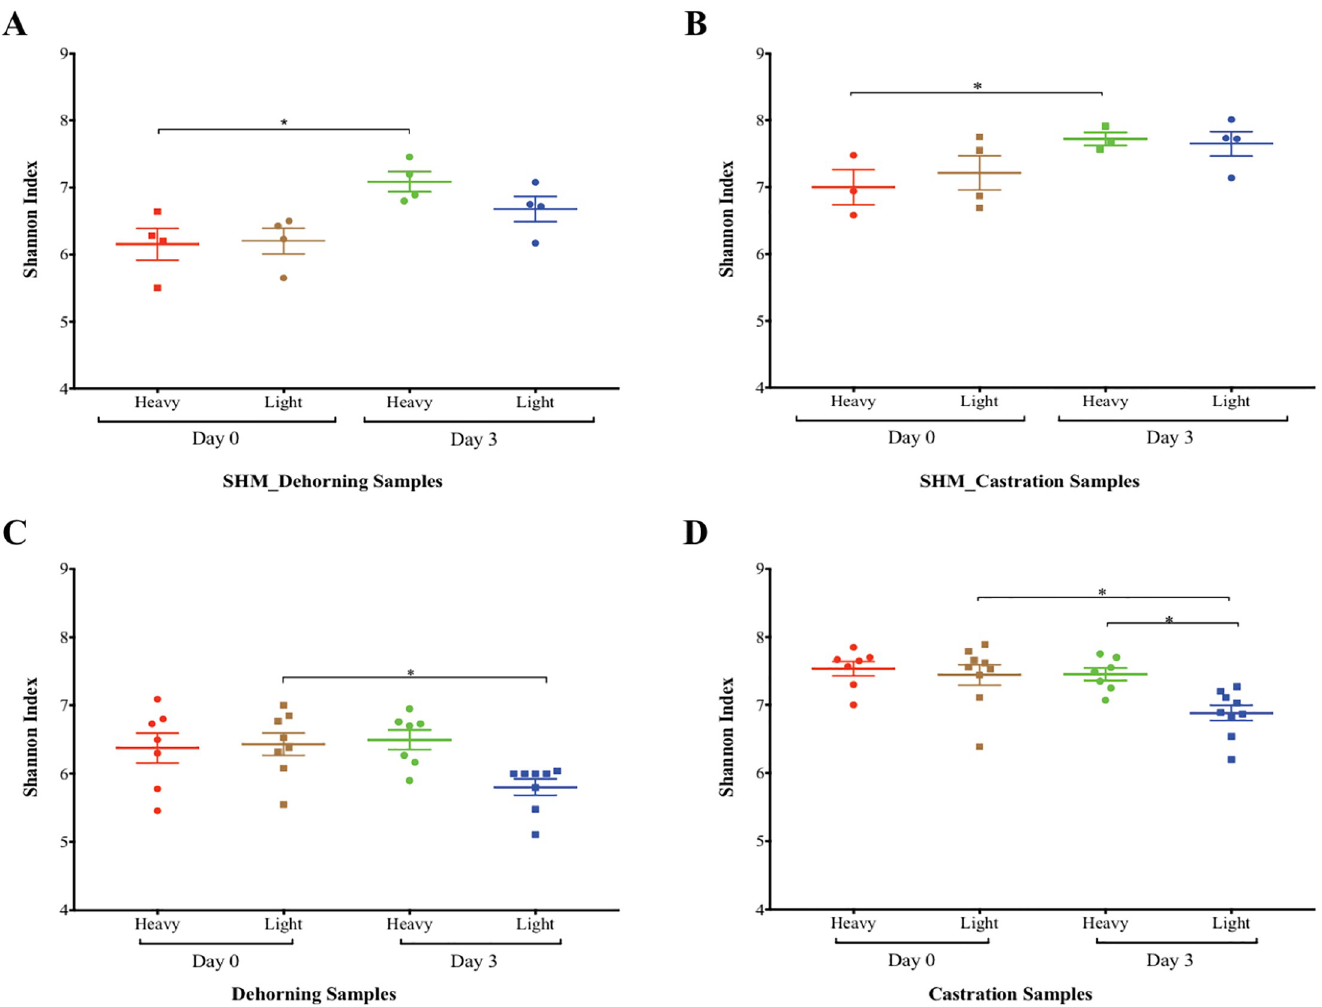
Fig 2. Shannon index before (Day0) and after (Day3) calves were exposed to the sham procedures or stressors (dehorning/castration). (A) and (B), scatter plot of Shannon index (mean ± SEM) for SHM calves (grouped according to body weight) at Day 0 and Day 3 of sham-dehorning (n = 8) and sham-castration (n = 7), respectively. (C) and (D), scatter plot of Shannon index for stressed calves (grouped according to body weight) at Day 0 and Day 3 of dehorning and castration, respectively. Shannon diversity measures were compared between light and heavy calves using the Student’s T-test with a significance threshold of p -value < 0.05.